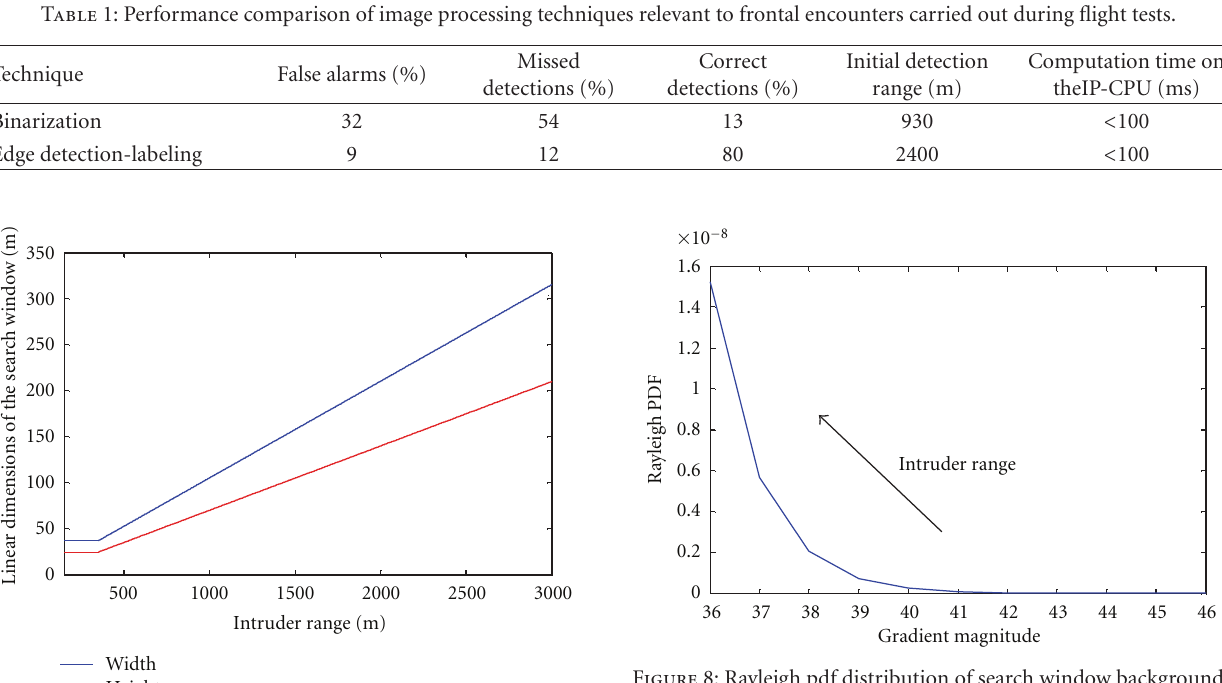
Figure 6: Search window: law of variation.